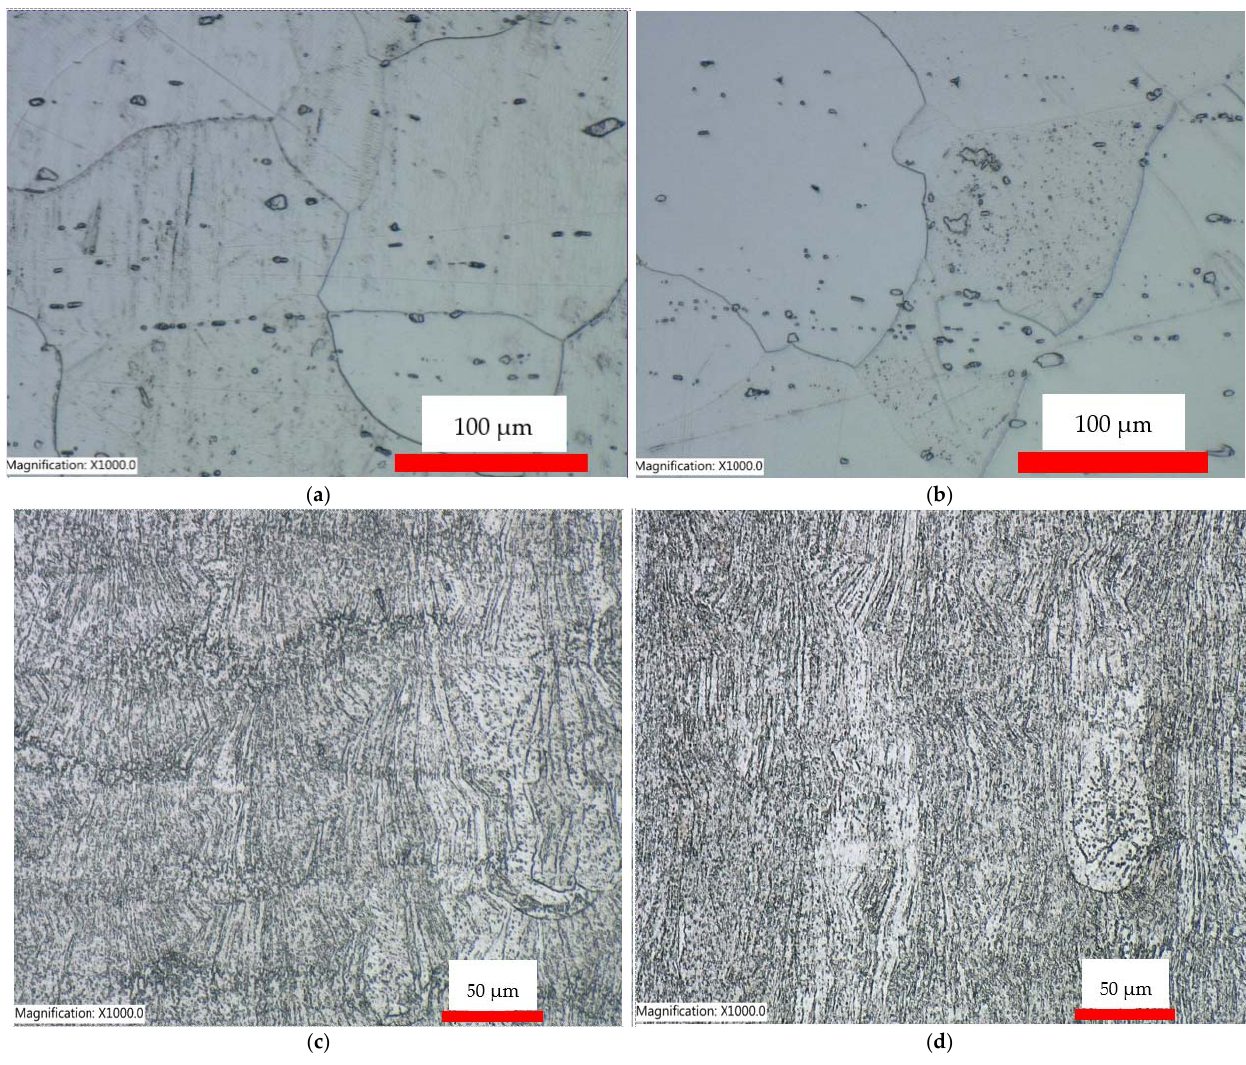
Figure 6. Microstructural images of ( a ) cast ‐ HT1; ( b ) cast ‐ HT2; ( c ) printed ‐ HT1; ( d ) printed ‐ HT2 samples.